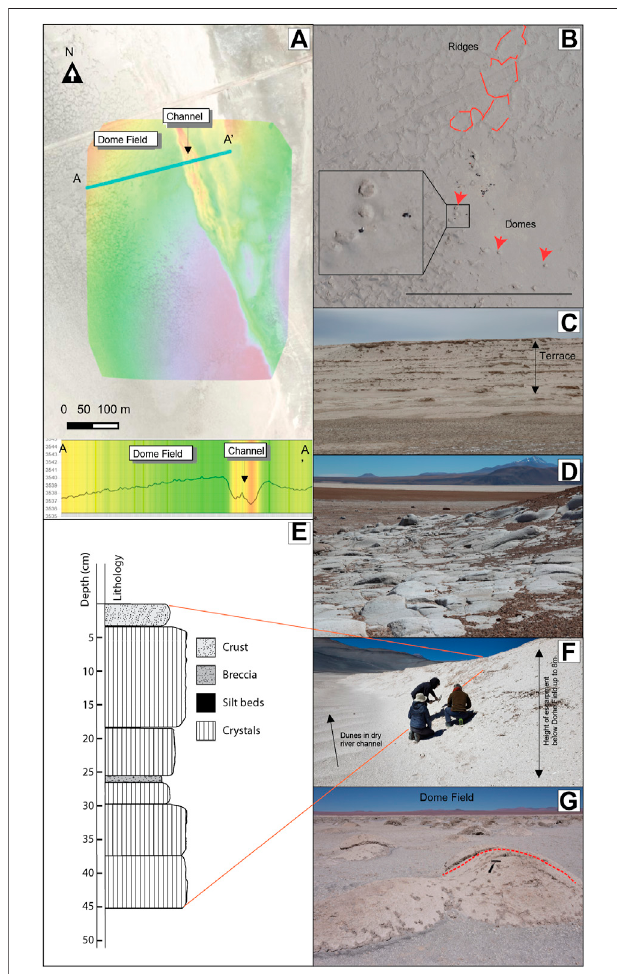
FIGURE 2 | (A) Shaded DEM of study area with A-A ′ elevation transect. Maps and cross section were created in Cartalytics (www.cltix.com); aerial imagery is downloaded from the Lea fl et open-source library (https://lea fl etjs. com/). (B) Air photo of study site with Domes (red arrows) and randomly oriented ridge segments that connect to form irregular Megapolygons (outlined indashed red lines). (C) Paleoterraces ofexposed gypsum beds. (D) Rhyolite surface eroded by abrasive fl ooding. Field of vew ca 25 m. (E) Drainage cut through gypsum bed looking south. The Dome Field is to the right on the top of the gypsum terrace. (F) Stratigraphy column illustrating cyclic deposition in the upper 0.5 m of salar surface at the Dome Field. The surface layer is a coherent but breakable crust of cemented grains extending downward between crystals from the underlying layer. Crystal beds are vertically oriented selenite. Silt beds are thin, recessive laminar beds comprising detrital crystals and grains. Breccia layers comprise fl at lying selenite that is very friable. (G) Dome fi eld looking west. A dashed red line highlights the dome in the center